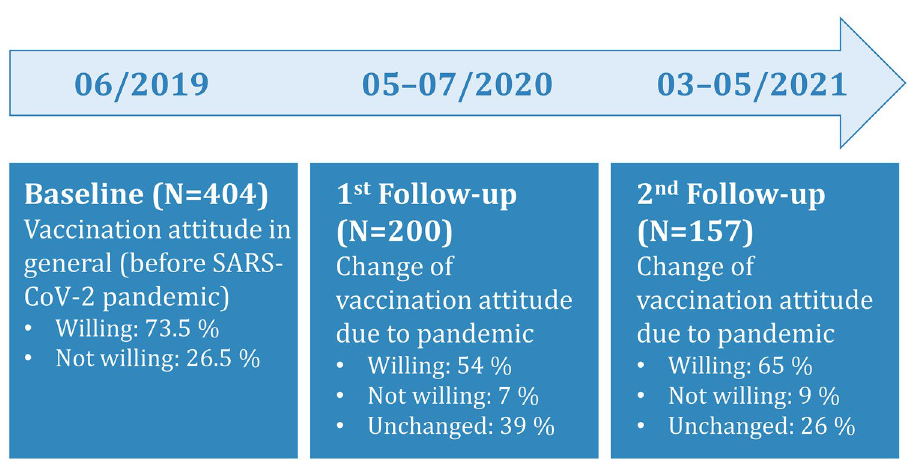
Figure 2. Development of general vaccination attitude before and during the course of the SARS-CoV-2 pandemic. N number of patients, SARS-CoV-2 Severe acute respiratory syndrome coronavirus